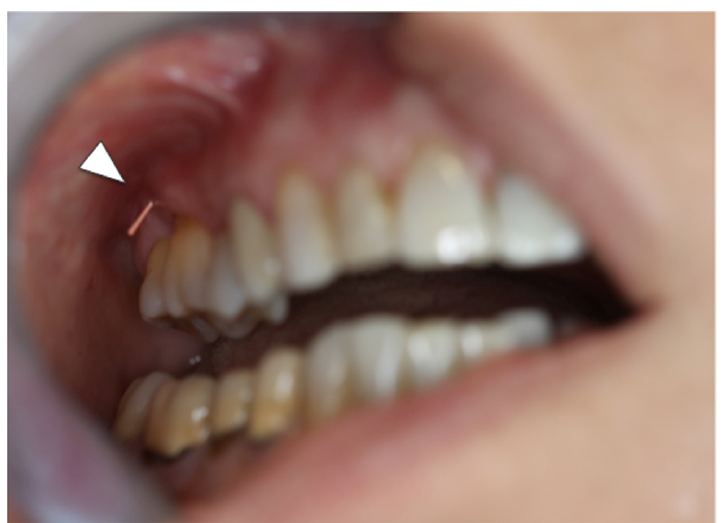
Figure 1. Intraoral patient’s image at presentation showing a mucosal fistula in the vestibular buccal sulcus at the upper first right molar with mild gingival inflammation. An endodontic cone was used for dentoalveolar sinus track magnification (white arrowhead). The panoramic radiograph showed a focal sclerosis of the alveolar bone surrounding the first right molar and a thickening of the lamina dura (Figure 2).